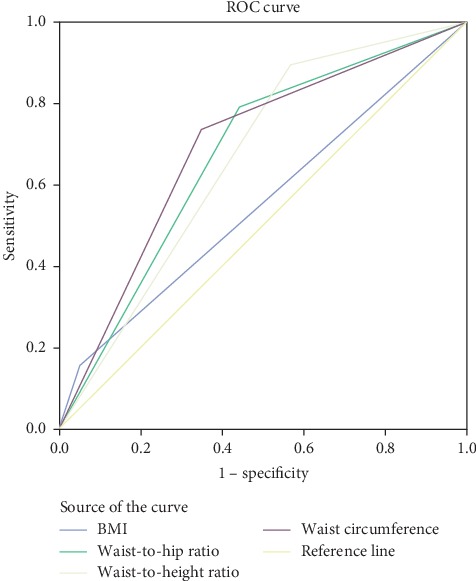
Receiver operating characteristic curve of body mass index (BMI), waist circumference (WC), waist-hip ratio (WHR), waist-to-height ratio (WHtR), and waist-to-square height ratio (WHt2R) to diabetes mellitus in female.